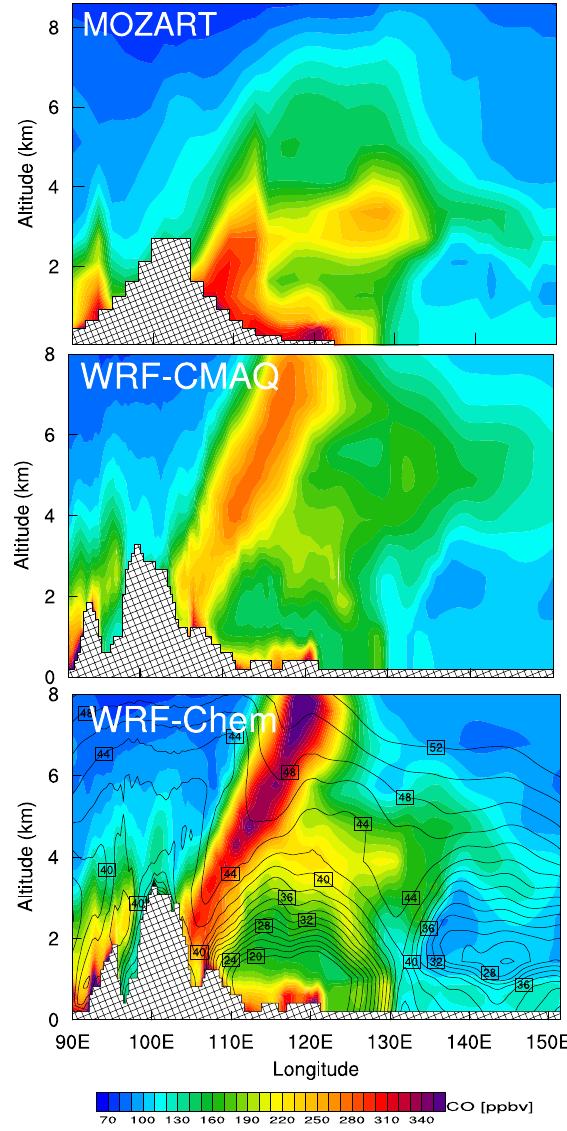
Figure 5. Comparison of model simulated convective and updraft mixing of CO in association Fig. 5. Comparison of model simulated convective and updraft mix- with the passage of the cyclonic wave during 6-7 March. Shown are vertical distributions of CO ing of CO in association with the passage of the cyclonic wave dur- ing 6–7 March. Shown are vertical distributions of CO (filled) and (filled) and equivalent potential temperature (contours) along the frontal system convergence band equivalent potential temperature (contours) along the frontal system indicated in Figure 4. convergence band indicated in Fig. 4. The hatched areas indicate that surface pressure is below the bottom pressure level used for vertical